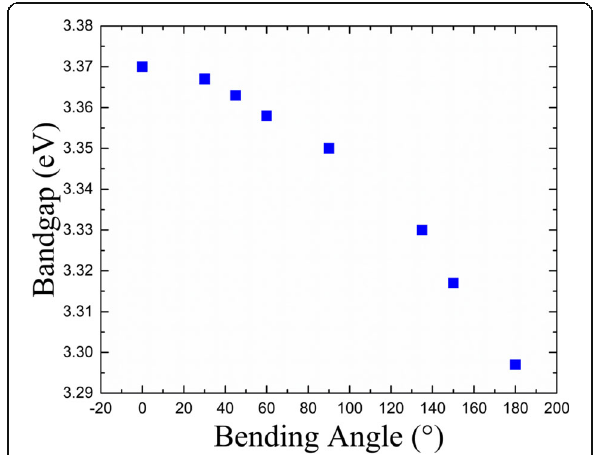
Fig. 6 Bandgap of ZnO MWs at different bending angles